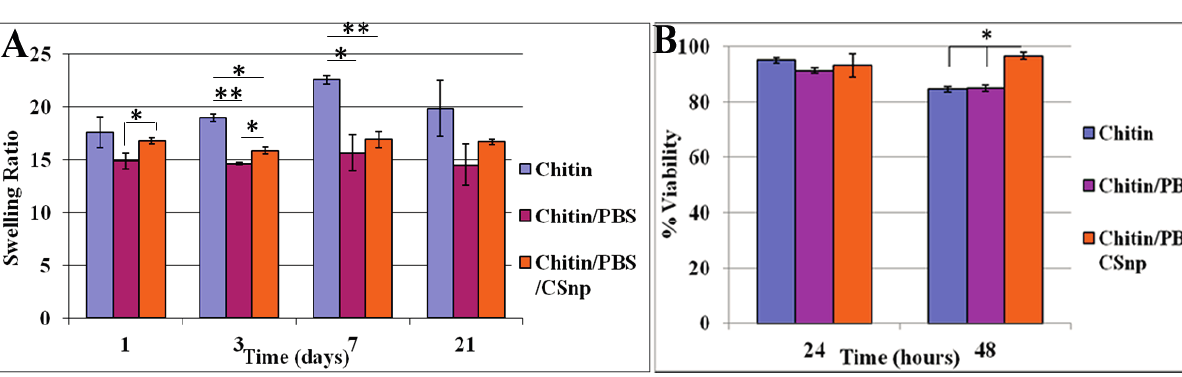
Figure 5. ( A ) Swelling study of chitin, chitin PBS and chitin/PBS/CSnps in PBS and ( B ) Alamar blue assay to determine viability of HDFs on chitin, chitin PBS and chitin/PBS/CSnps after 24 and 48 h. * indicates p < 0.05 and ** indicates p <